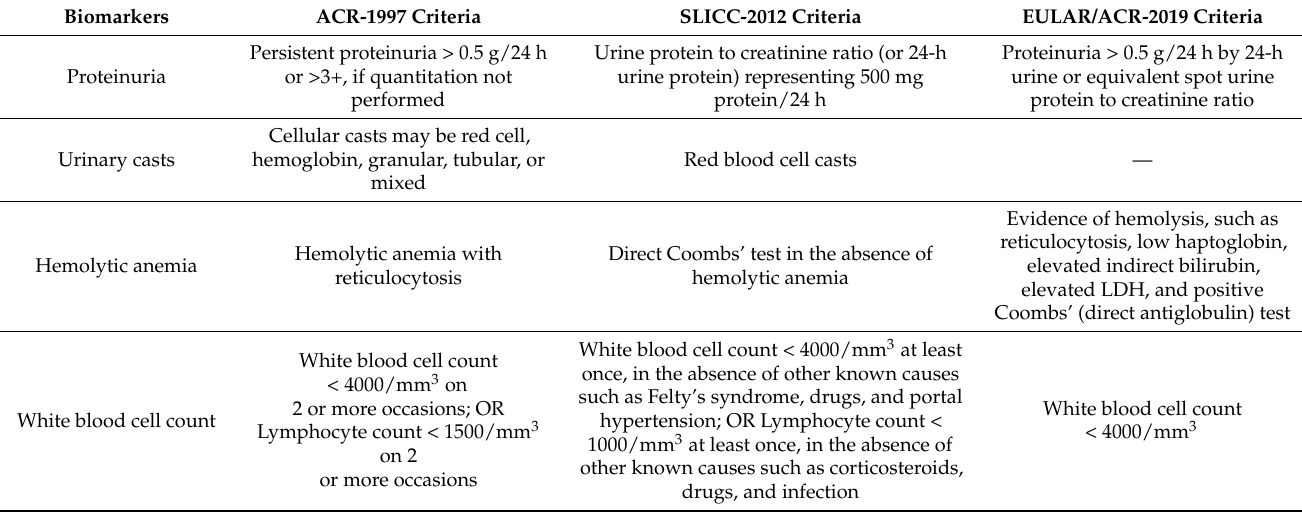
Table 1. Biomarkers for SLE in the defined criteria of ACR-1997, SLICC-2012, and